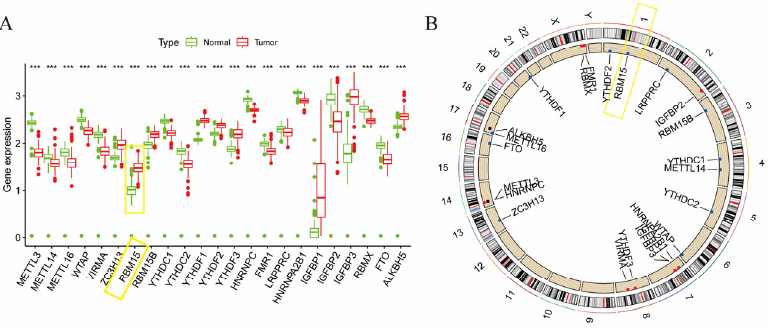
Figure 1. ( A ) Gene expression in normal and cancerous tissue; ( B ) Location of m6A regulators on the chromosome for CNV alteration ( *** p < 0.001, the yellow frame pointed to the gene RBM15 ).